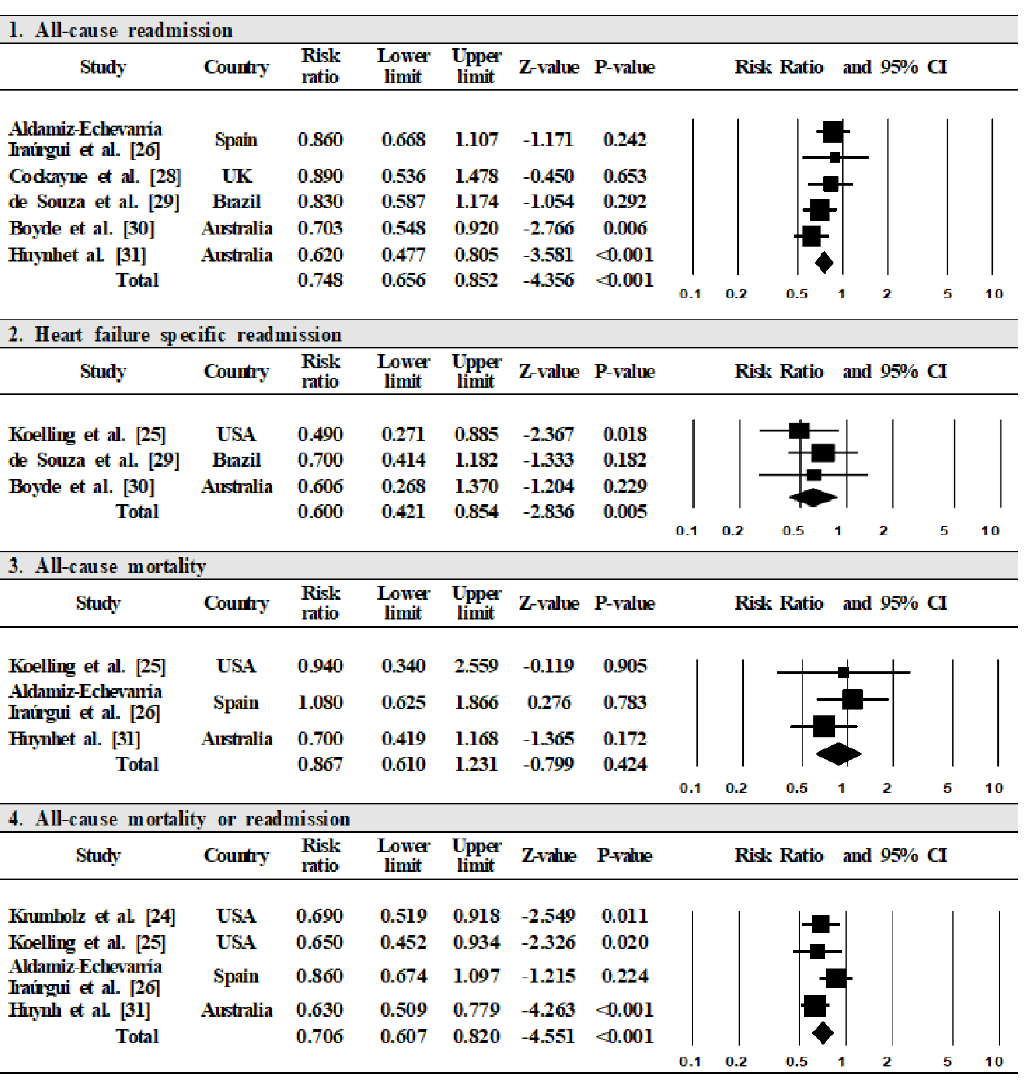
Figure 4. The effect of nurse-led self-care education intervention on health outcomes. Note: CI= confidence